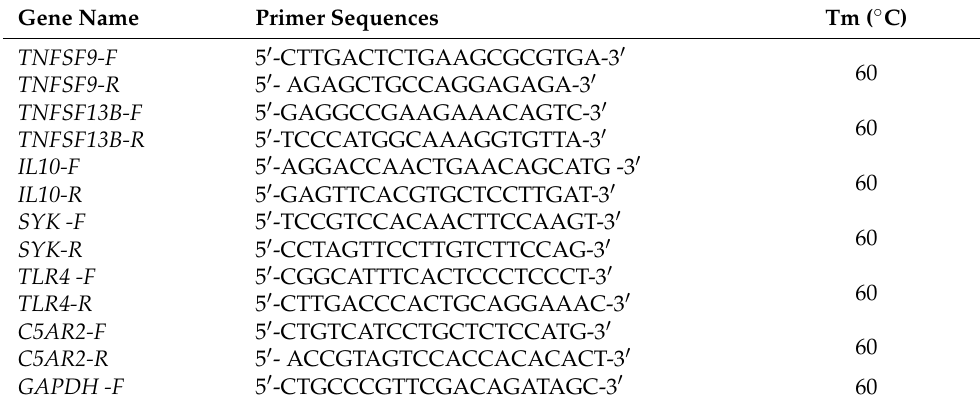
Table 2. Target genes and the primer sequences used in RT-PCR analysis of lamb